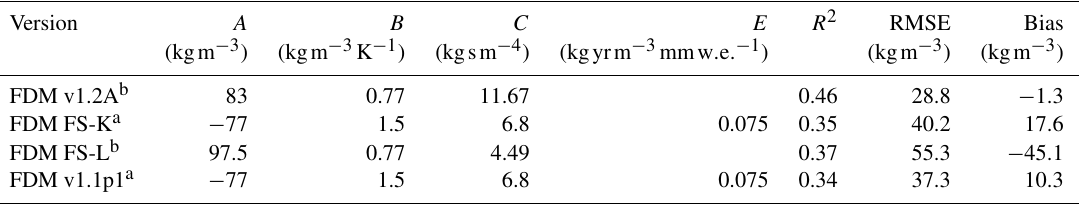
Table 3. Fit coefficients and evaluation of the fresh-snow density parameterizations (Eqs. 1 and 2). The fit coefficients of FDM FS-K and FDM FS-L are taken from Kaspers et al. (2004) and Lenaerts et al. (2012), respectively. Version